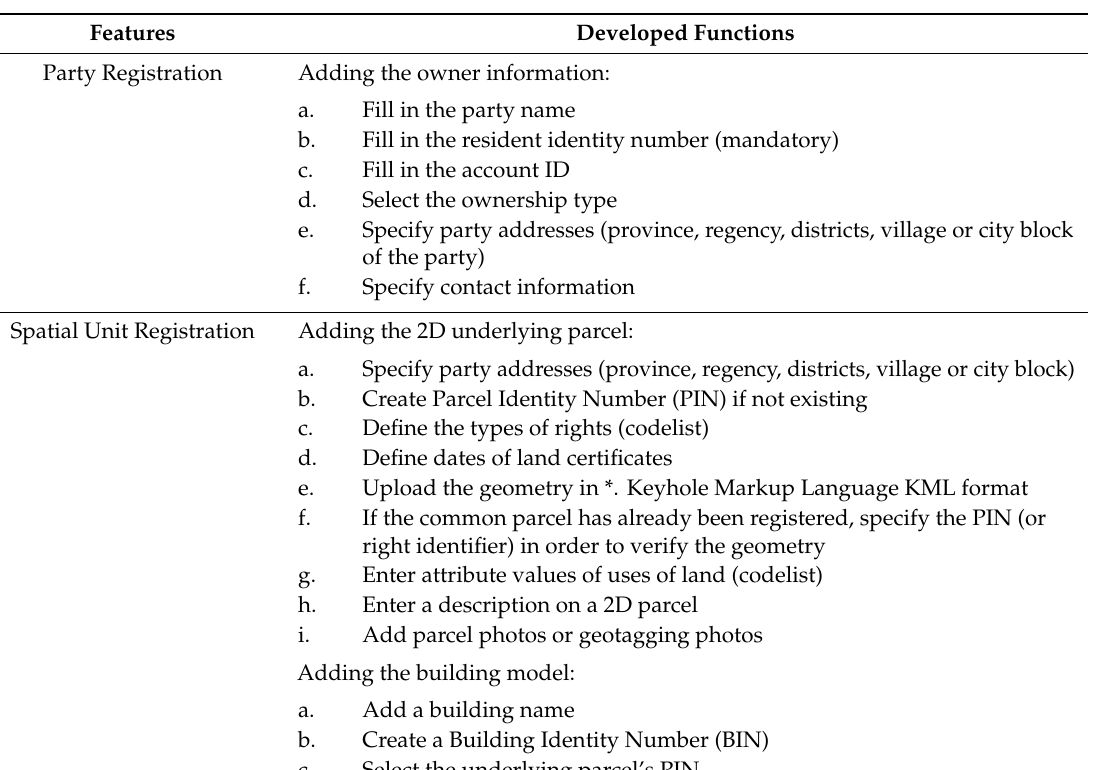
Table 2. List of important features and developed